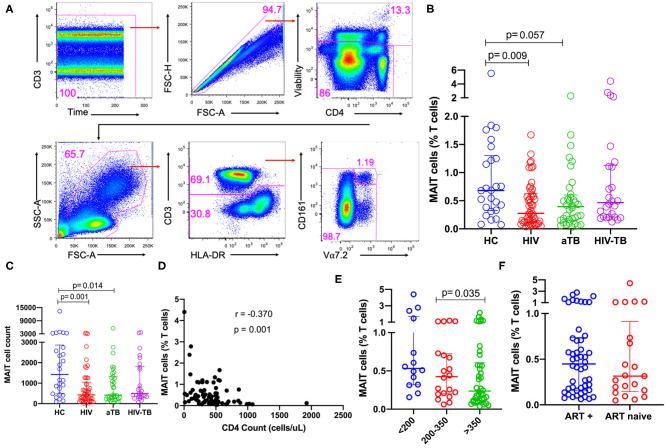
Frequencies of MAIT cells in patients with HIV infection, active TB, and HIV-associated TB. (A) Gating strategy used to identify MAIT cells. First, doublets and dead cells were excluded, then leukocytes selected, followed by CD3+ T cells. From the CD3+ T cells, MAIT cells were identified. (B) Frequencies of MAIT cells (%CD3 T cells) in HC, HIV, aTB, and HIV-TB. (C) MAIT cell counts (number of events in MAIT cell gate) in HC, HIV, aTB, and HIV-TB. (D) Relationship between MAIT cell frequencies and CD4 counts of HIV and HIV-TB group participants was investigated using Spearman rank correlation. (E) Effect of CD4 counts; and (F) ART on MAIT cell frequencies. P-values reported from Kruskal-Wallis test with a Dunn's post-hoc test for multiple comparisons and p < 0.05 reported as statistically significant. HC, Healthy controls group; HIV, HIV only group; aTB, active TB only group; HIV-TB, HIV-associated TB group.